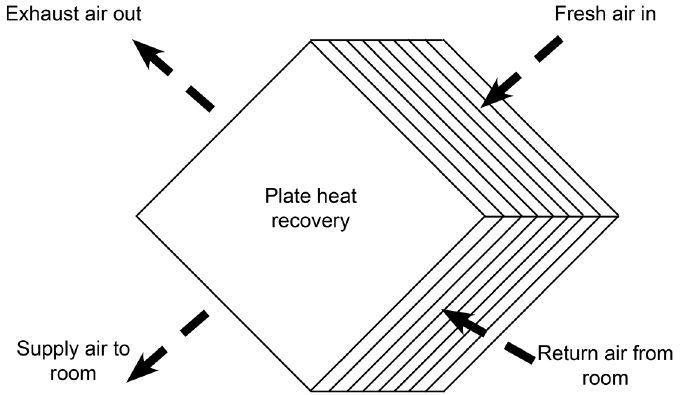
Figure 4. A fixed-plate heat exchanger [7]. Figure 4 . A fixed-plate heat exchanger [7]. Figure 4 . A fixed-plate heat exchanger [7].